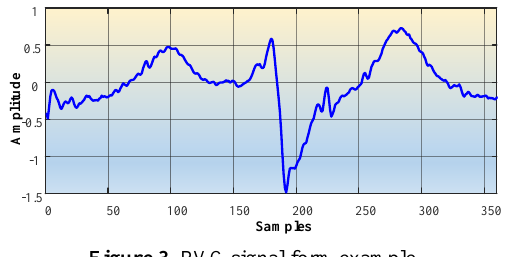
Figure 3. PVC signal form example.